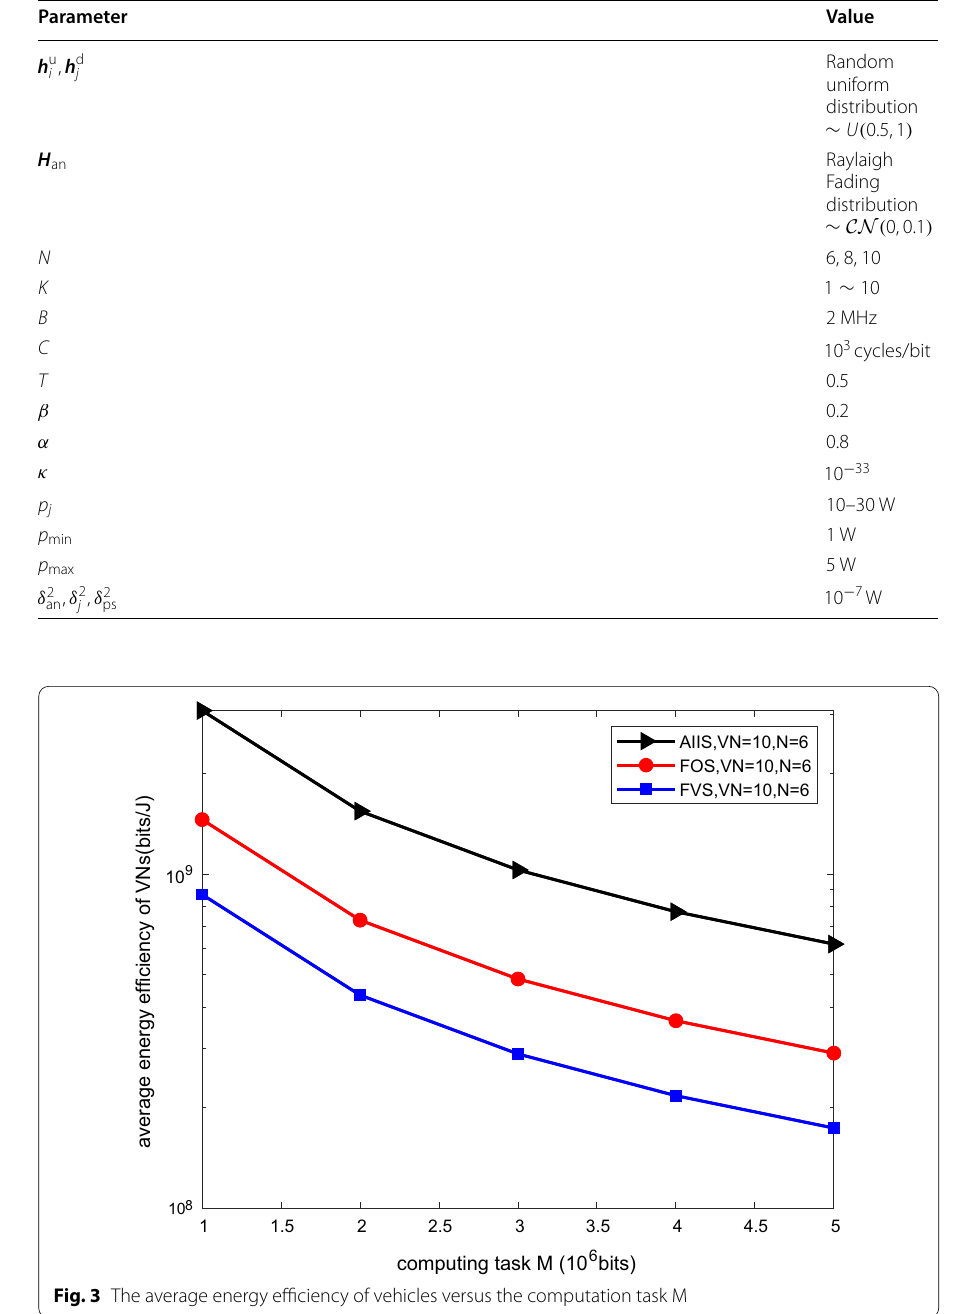
Table 1 Simulation parameters